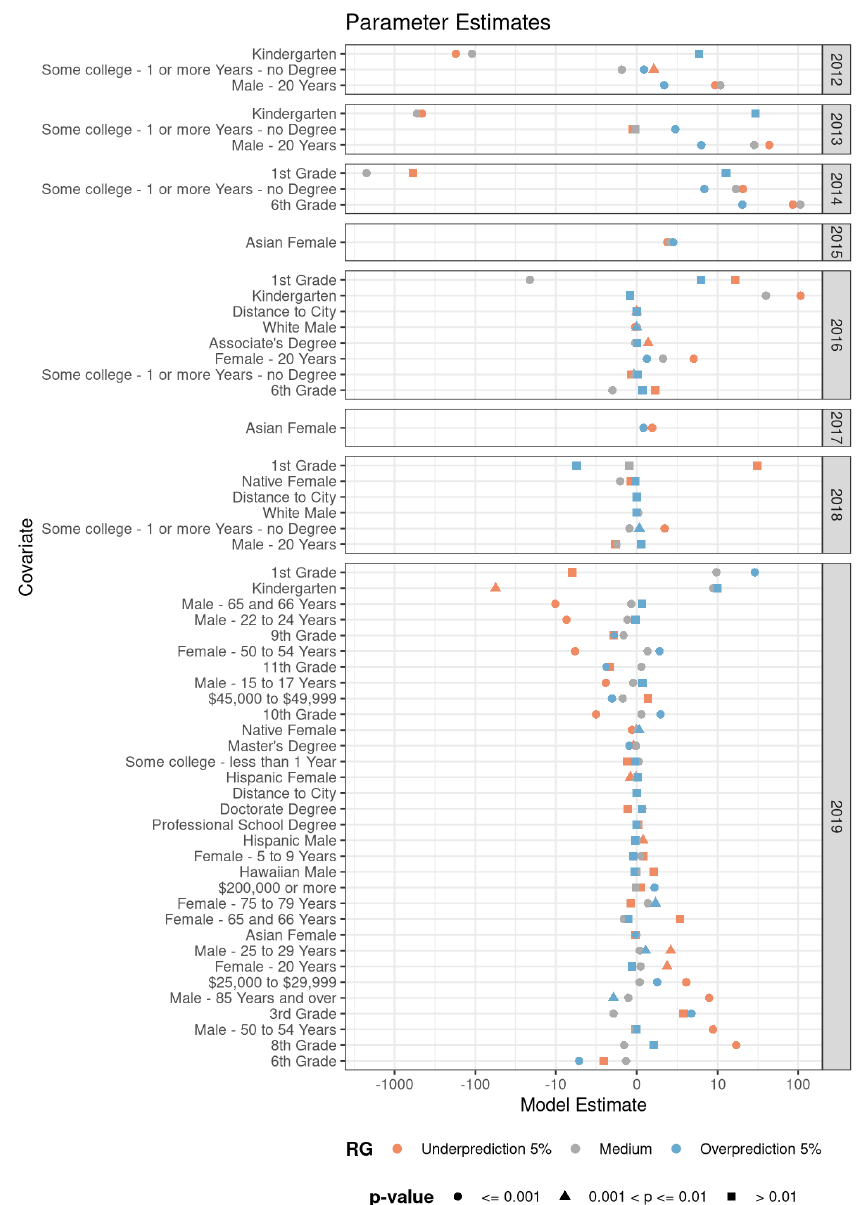
Figure 8. Effect size estimates for the covariates of the best performing models, separated by RG and